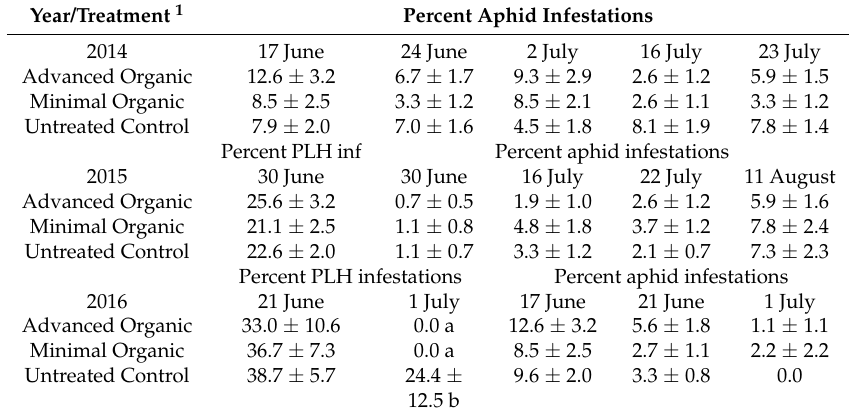
Table 3. Green aphid and potato leafhopper terminal infestations under different organic programs.